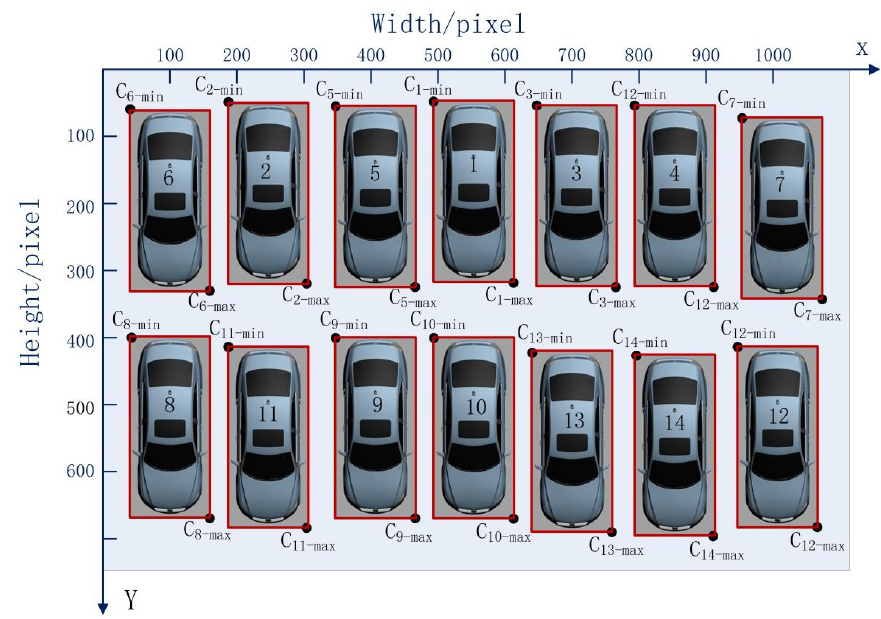
Figure 5. Each vehicle number after sorting with the TimSort algorithm. Given the difference in the length and width of various types of vehicles and the relative positional difference between a vehicle and a parking space, guaranteeing that the y min of each bounding box will be the same is difficult. Therefore, each parking space num- ber was confusing, as shown in Figure 5. To address this issue, the data layering method was used to layer the vertical direction using Equation (3):